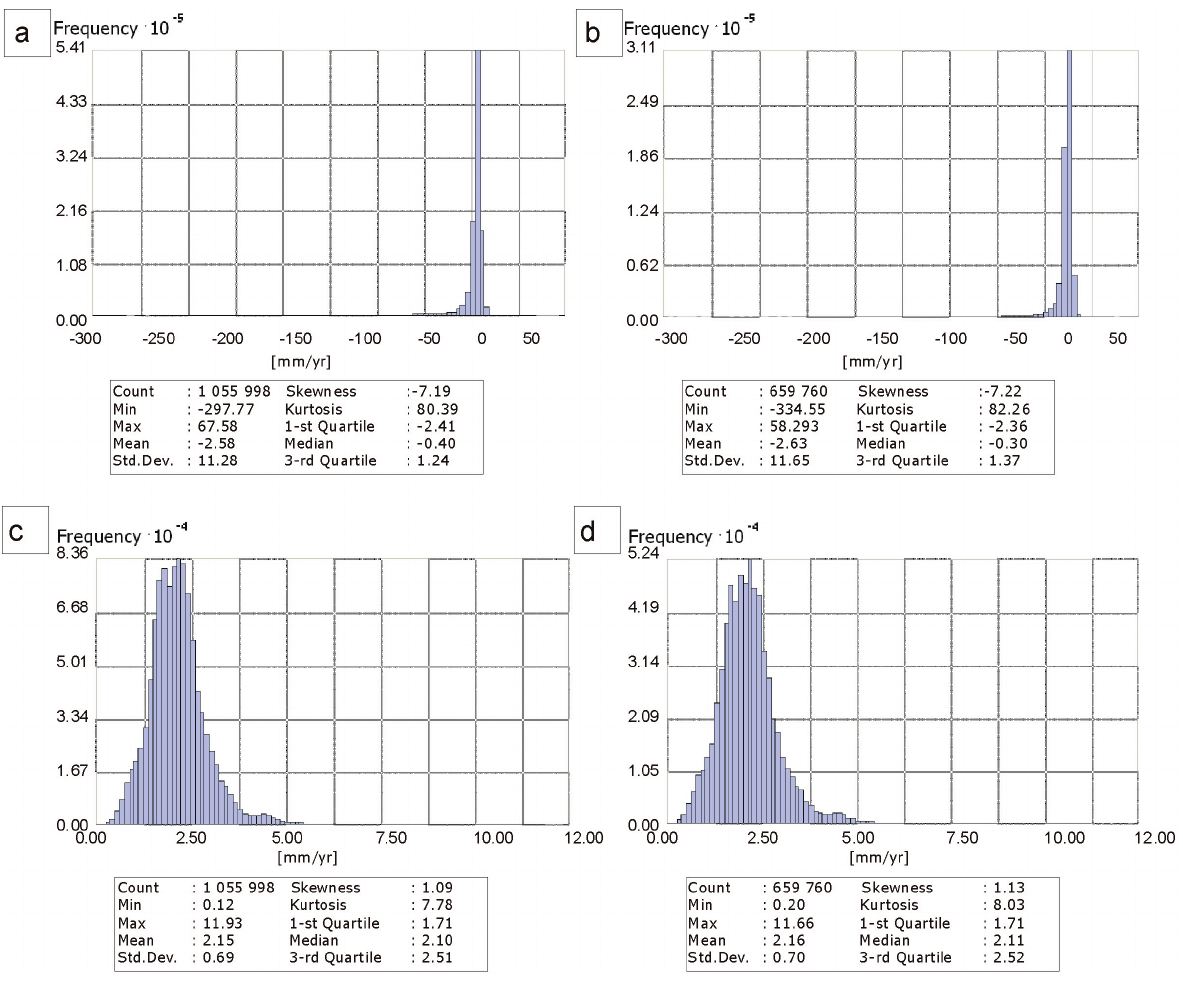
Figure 5. Permanent Scatterers Interferometry (PSI) dataset histograms. ( a ) Histogram of point scatterers (PS) Line of Sight (LOS) velocity; ( b ) histogram of distributed scatterers (DS) LOS velocity; ( c ) histogram of PS velocity standard deviation; and ( d ) histogram of DS velocity standard